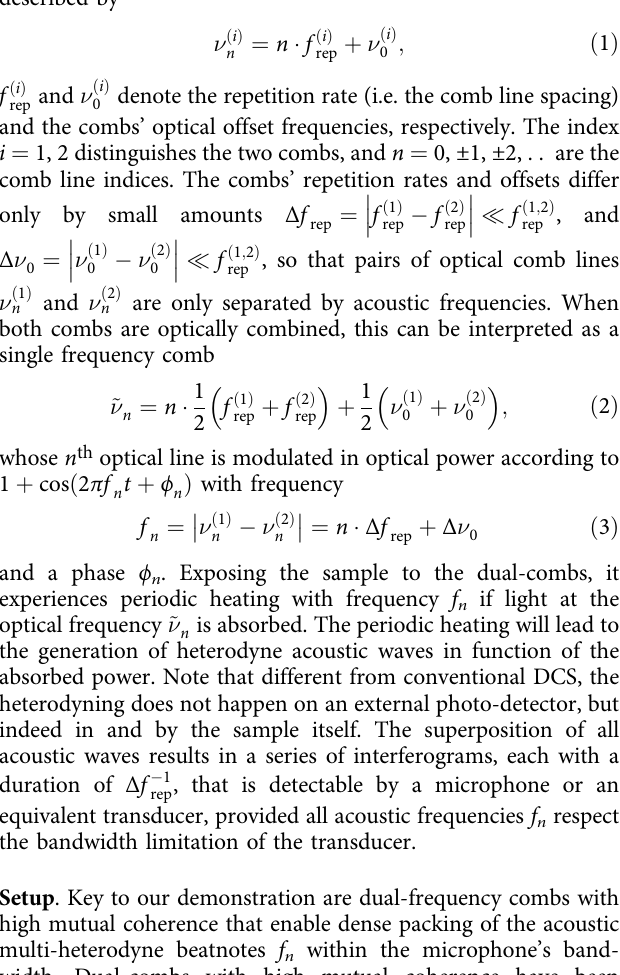
and f ð 2 Þ rep rep